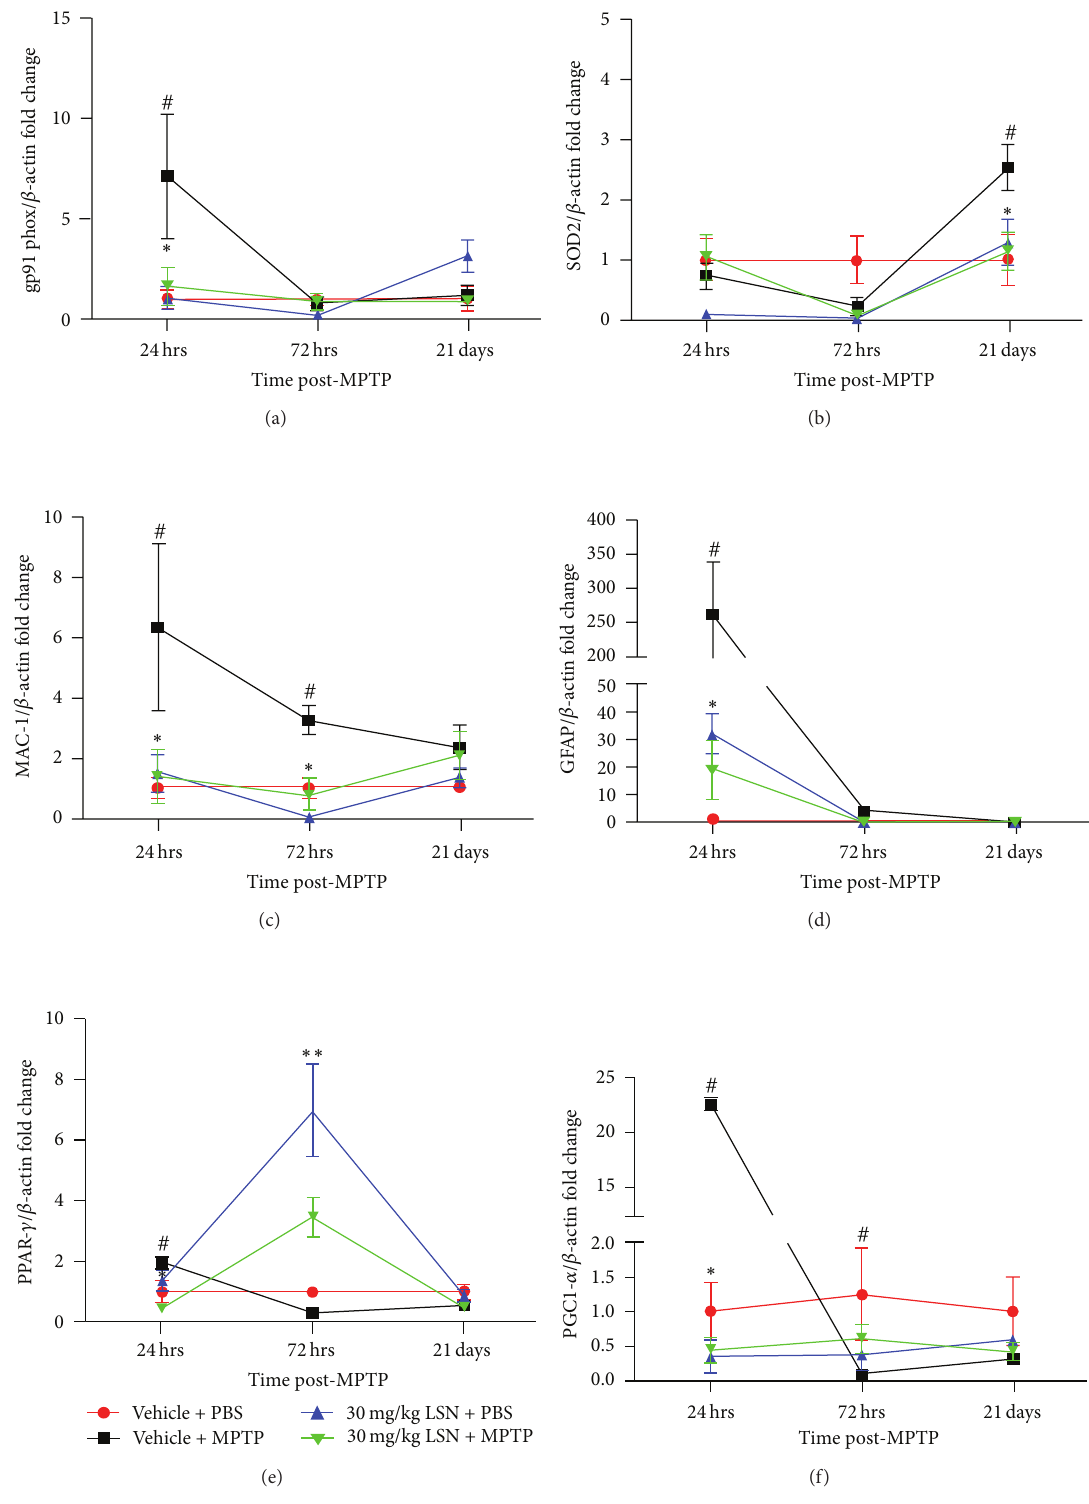
Figure 4: LSN862 (LSN) affected mRNA expression at 24 hrs, 72 hrs, and 21 days post-MPTP. Quantitative PCR analysis of nigral (a) gp91 phox, (b) SOD2, (c) MAC-1, and (d) GFAP and striatal (e) PPAR- 𝛾 , (f) PGC1 𝛼 mRNA levels. The groups were vehicle + PBS (24hrs: 𝑛 = 5 ; 72 hrs: 𝑛 = 4 ; 21 days: 𝑛 = 4 ); vehicle + MPTP (24hrs: 𝑛 = 5 ; 72hrs: 𝑛 = 5 ; 21 days: 𝑛 = 6 ); 30mg/kg LSN + PBS (24hrs: 𝑛 = 4 ; 72 hrs: 𝑛 = 3 ; 21 days 𝑛 = 4 ; 30mg/kg LSN + MPTP (24 hrs: 𝑛 = 5 ; 72 hrs 𝑛 = 4 ; 21 days 𝑛 = 5 ). Data is expressed as fold change from vehicle + PBS controls relative to 𝛽 -actin (mean ± SEM). Two-way ANOVA with repeated measures, # 𝑃 < 0.05 (vehicle + MPTP versus vehicle + PBS), ∗ 𝑃 < 0.05 (vehicle + MPTP versus 30mg/kg LSN + MPTP), and ∗∗ 𝑃 < 0.05 (vehicle + PBS versus 30 mg/kg LSN +